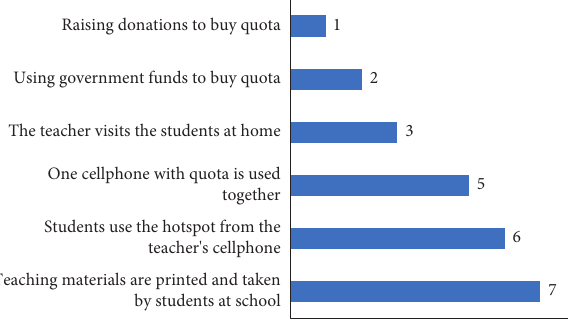
Figure 3: Teachers’ initiative to solve the learning problem.